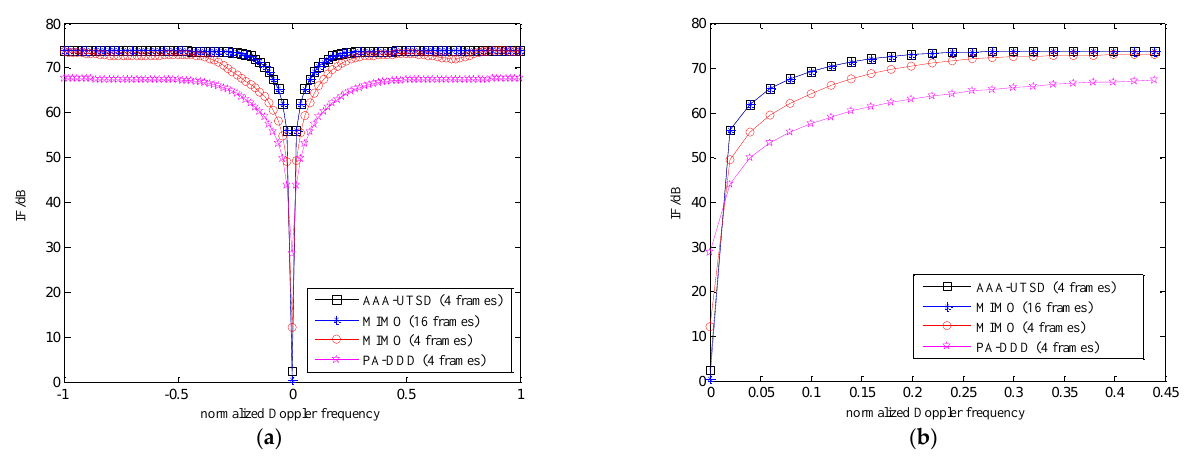
Figure 10. Improved factor comparison of different radar systems: ( a ) improved factor comparison; ( b ) local improved factor comparison.